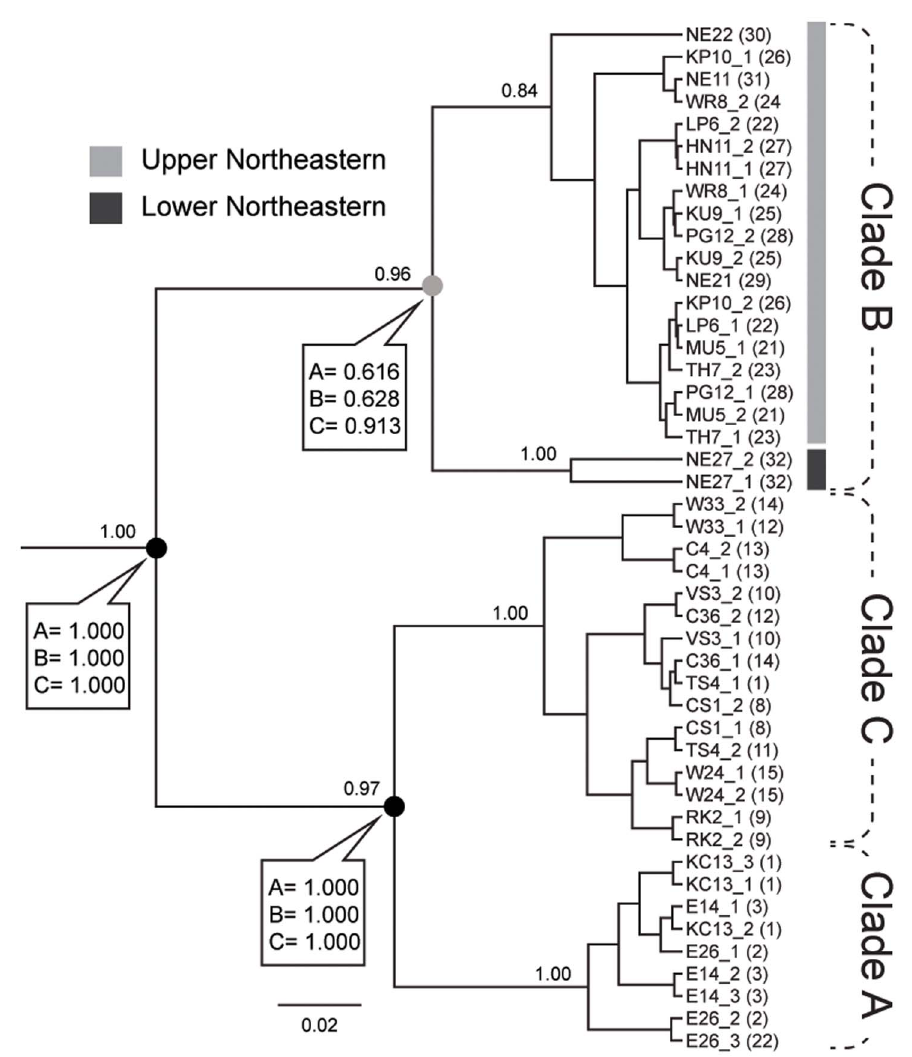
Figure 2. *BEAST species tree inference output based on all loci for the C.fulguratus – complex. Black nodes show 95% speciation probability support values in Bayesian species delimitation; Gray nodes are not supported in over 95% by Bayesian species delimitation. Posterior probability for supported branches generated by *BEAST are shown above the branches and speciation probabilities of a Bayesian species delimitation are provided in box for each node under each combination of priors: A, relatively large ancestral population size and shallow divergences; B, relatively large ancestral population size and deep divergences; and C, relatively small ancestral population size and shallow divergences. The 95% of speciation probability value is considered as strong support for a speciation event and is shown for each node. doi:10.1371/journal.pone.0109785.g002 PLOS ONE |